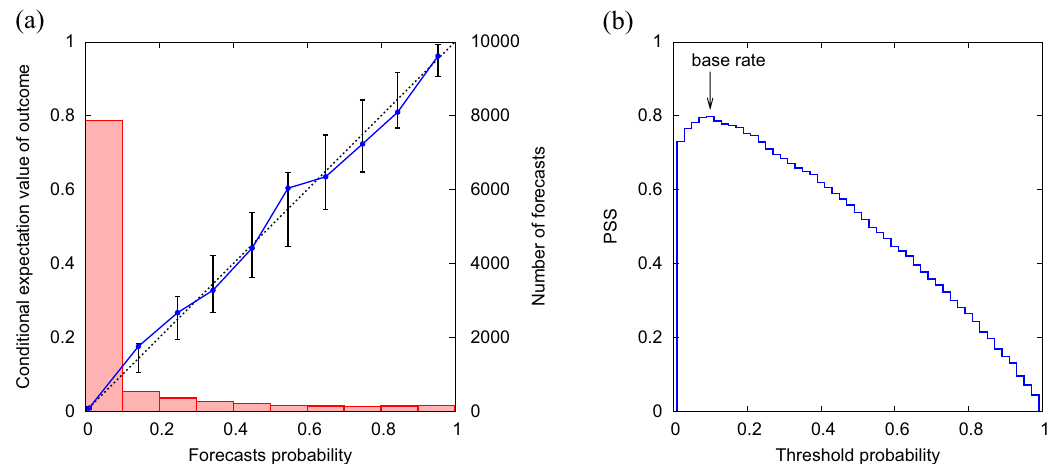
Fig. 1. (a) Reliability diagram for case 1. Blue dots connected by lines depict the conditional expectation values of outcome. A perfect reliability curve is depicted by the diagonal dashed line, on which the 99% consistency bars are drawn as vertical dashes. Red histograms with the right axis show the number of probabilistic forecasts within bins. (b) PSS versus threshold probability for case 1.